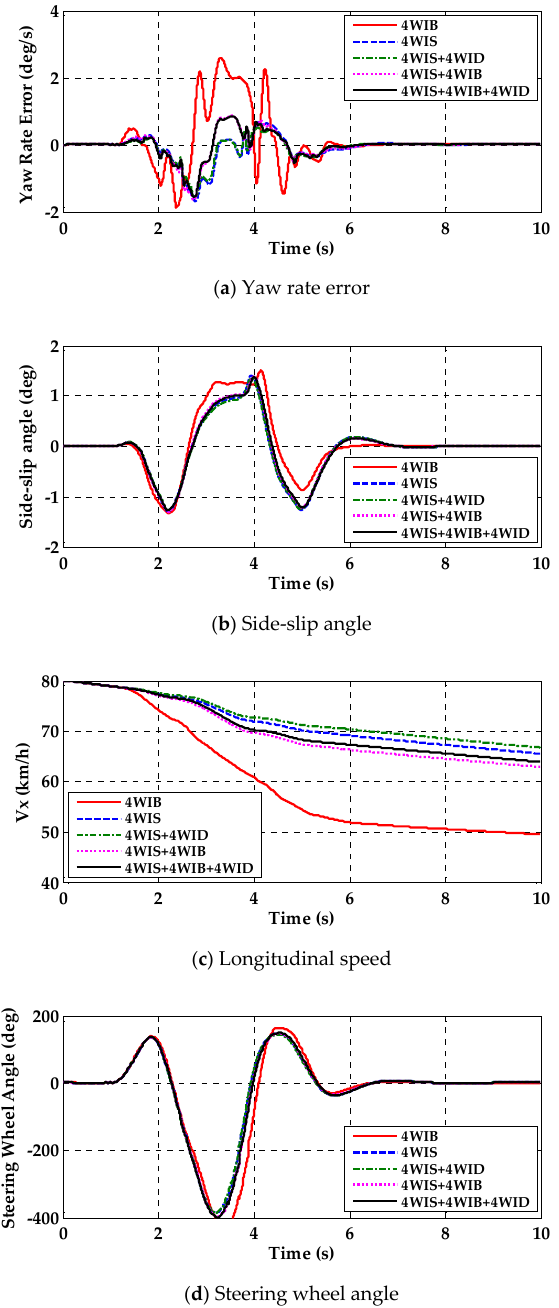
Figure 8. Simulation results for each actuator combination.